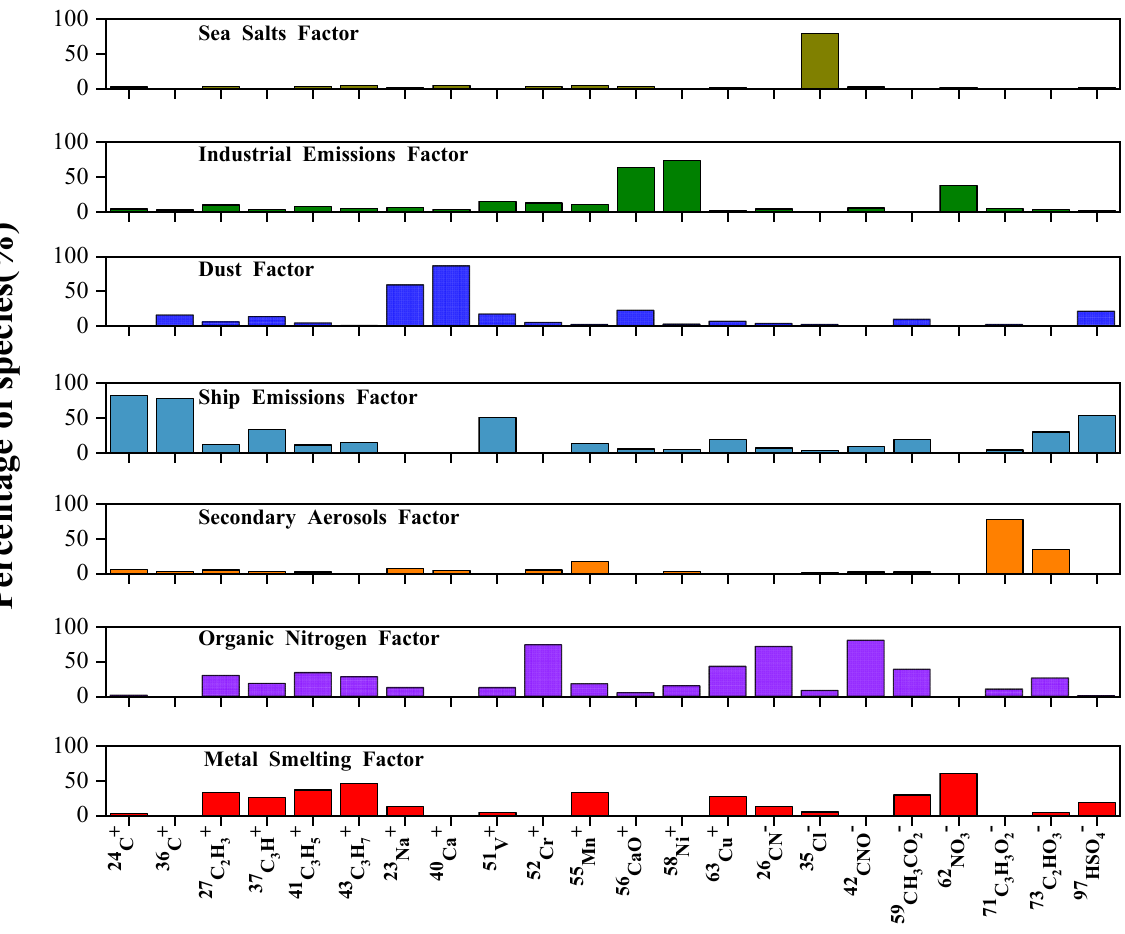
Figure 6. The PMF-resolved factors and their relative contributions to the predicted V-containing particles.